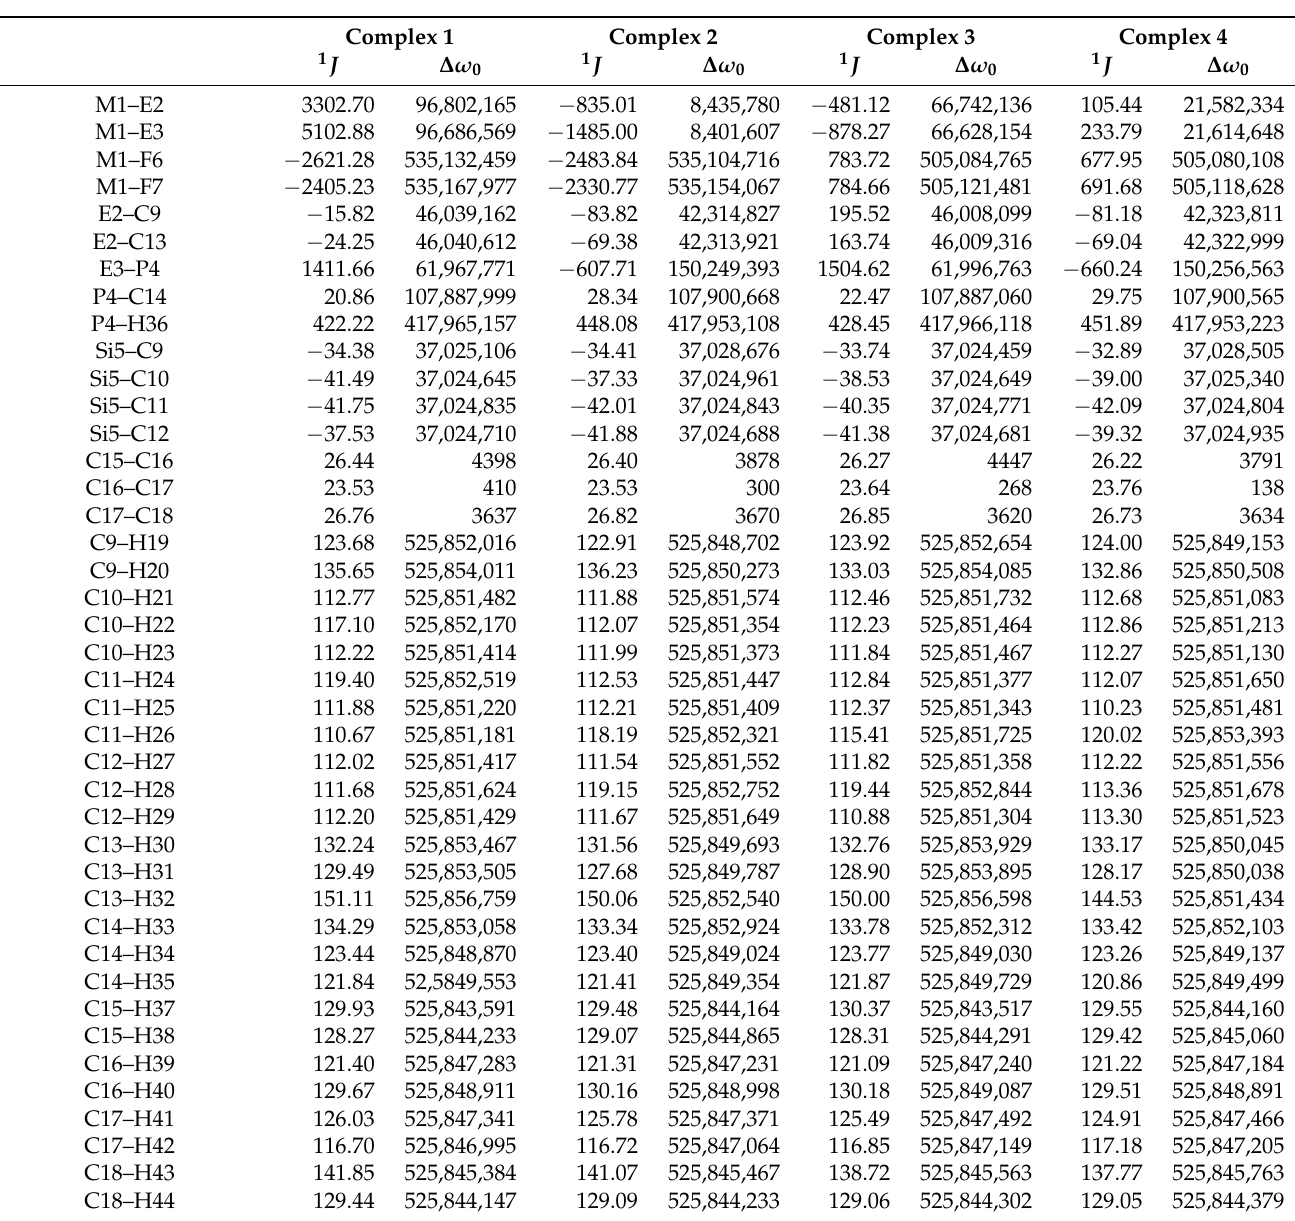
Table 3. Spin–spin coupling constants for directed coupled nuclei ( M = 113 Cd or 199 Hg and E = 77 Se or 125 Te), J (Hz), and differences in the Larmor frequencies (for a 16.5 T magnet) between the coupled nuclei, ∆ ω 0